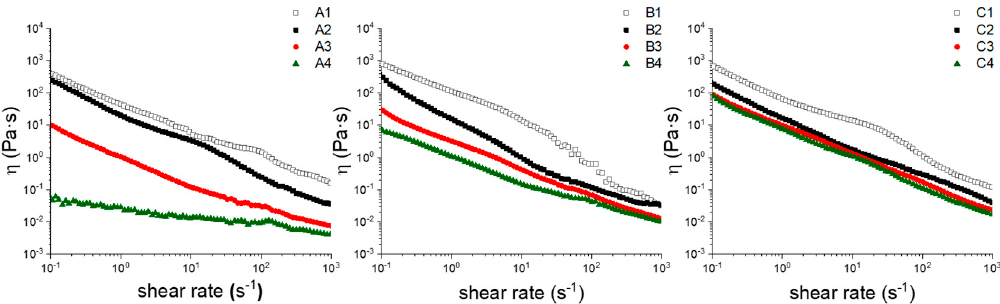
Figure 3. Dynamic viscosity ( η , Pa·s) as a log-log function of shear rates at different TOUS-CNFs and Ca 2+ concentrations. A: TOUS-CNFs 0.5% w / v ; B: TOUS-CNFs 1.0% w / v ; C: TOUS-CNFs 2% w / v . Symbols: □ [Ca 2+ ] = 10 mM; ■ [Ca 2+ ] = 5 mM; ● [Ca 2+ ] = 2 mM; ▲ [Ca 2+ ] = 0 mM.